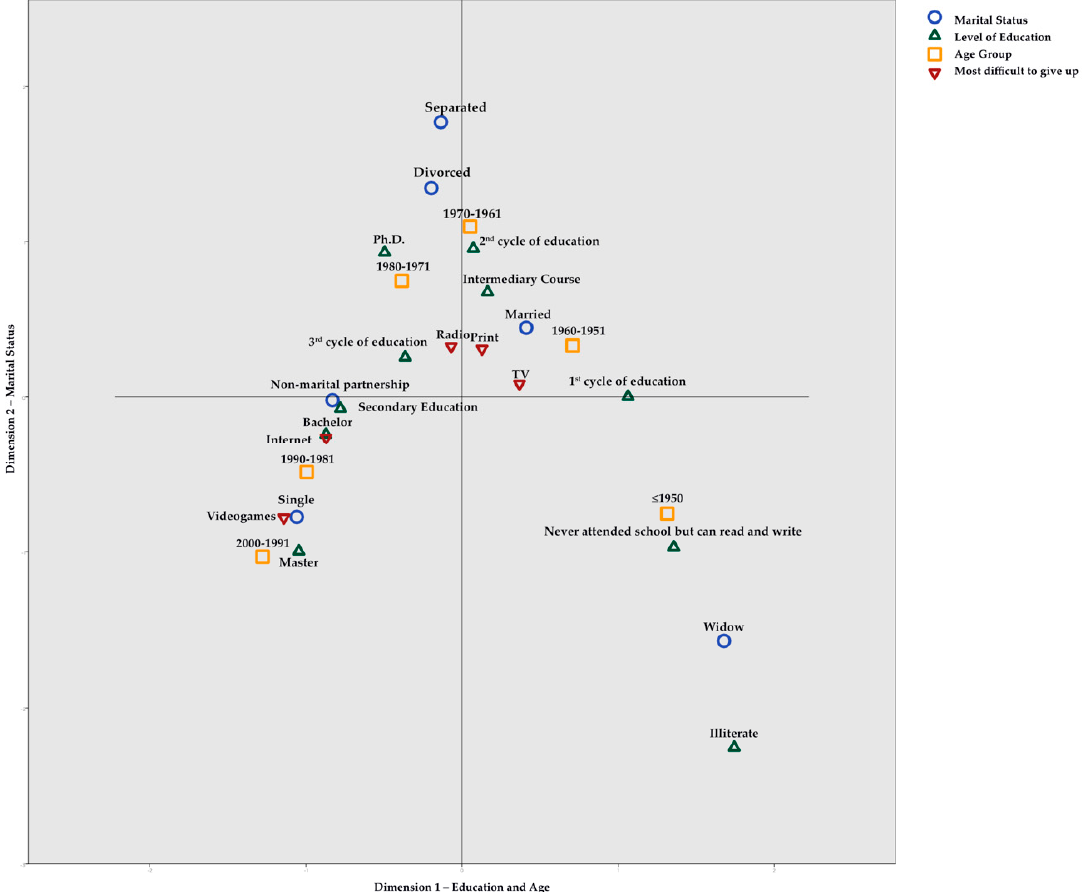
Figure 7. Multiple correspondence analysis. Source: ERC2015—The new dynamics of audio-visual consumption in Portugal; n = 1018.